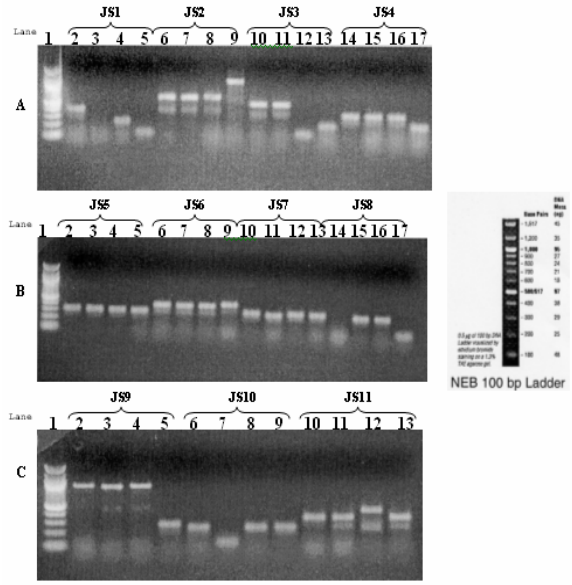
apoptotic death.